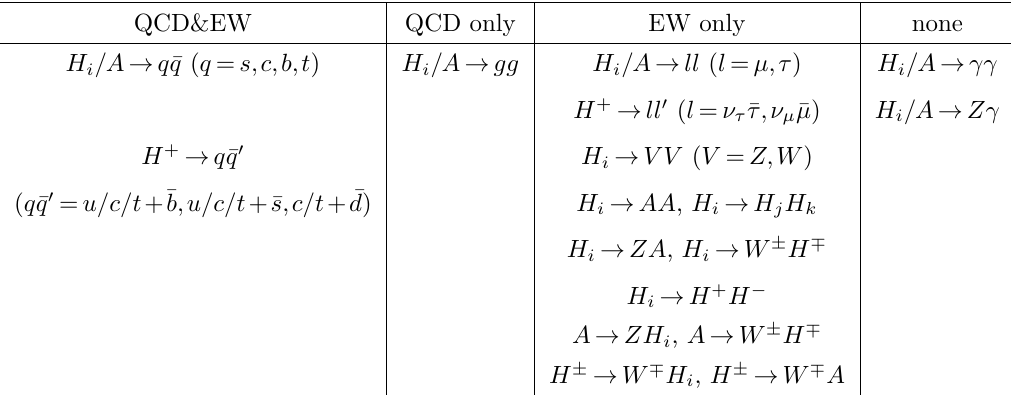
H k ; AA (cid:3) , H i ! Z (cid:3) A , H i ! W (cid:6)(cid:3) H (cid:7) j